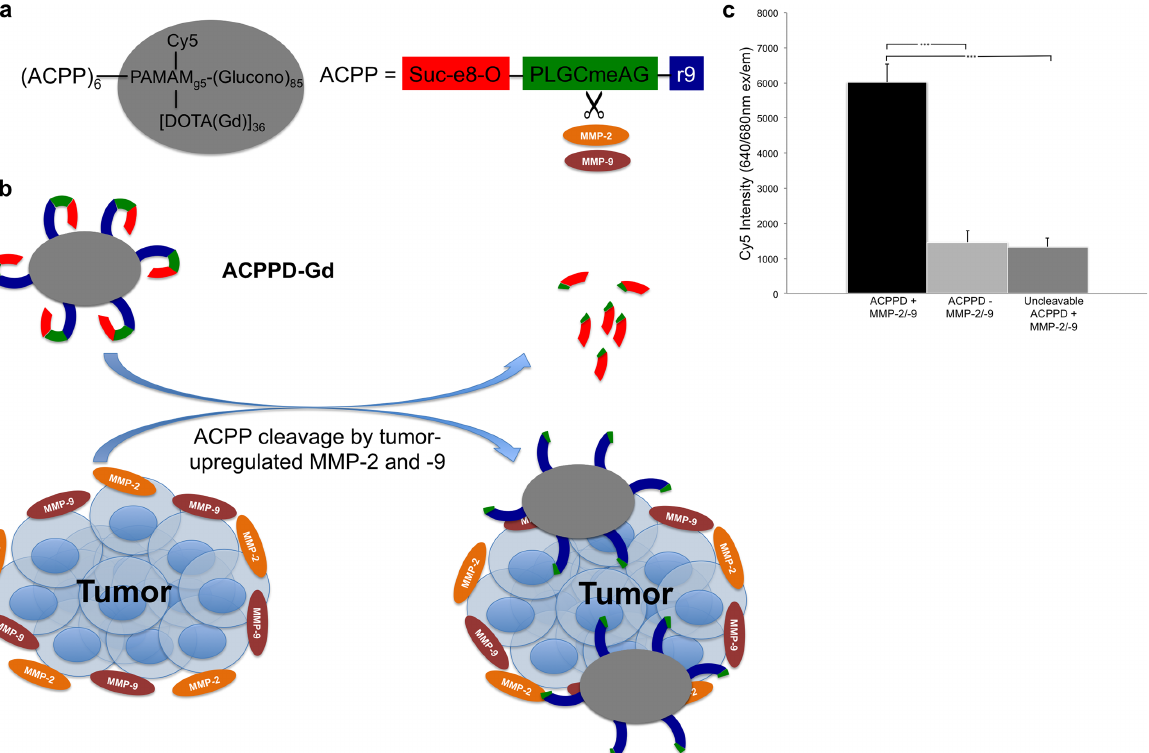
Fig 1. Overview of ACPPD-Gd structure and function. a , The overall structure of the ACPPD-Gd dendrimer as previously described (20). Here, the payload consists of 36 Gd-DOTA and 1 Cy5 molecules for dual MR and fluorescence imaging. The PLGCmeAG peptide linker is cleaved in the presence of the proteases MMP-2 and -9, which are upregulated in tumors. b , After tumor protease-dependent cleavage of the ACPP linker, the polycation and polyanion peptides separate allowing the highly cationic polyarginine peptide, linked to the dendrimer with payload (Gd-DOTA and Cy5), to bind to tumor cells and stroma. c , ACPPD-Gd is preferentially cleaved and binds to Jurkat cells in the presence of recombinant MMP-2 and MMP-9 in vitro . The dendrimer used in our study demonstrated significantly higher binding to Jurkat cells in vitro after overnight incubation with MMP-2 and -9 as measured by Cy5 fluorescence, compared to dendrimer incubated without MMPs and an uncleavable dendrimer (PLGCmeAG replaced by hexa(ethyleneoxy)) incubated in the presence of MMPs under the same conditions. *** indicates p <